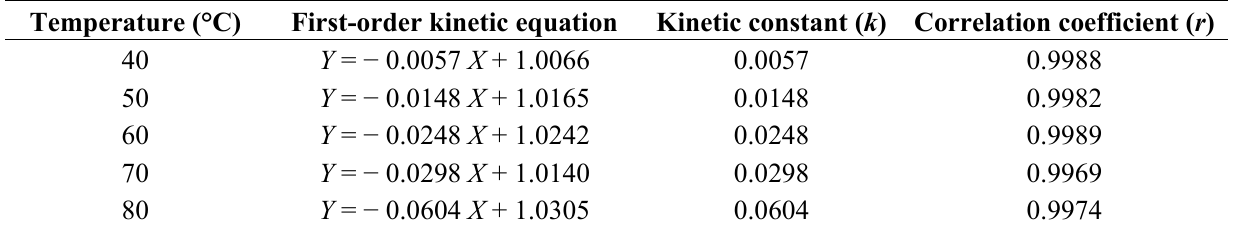
Table 4. Thermal degradation kinetic parameters of S. chinensis